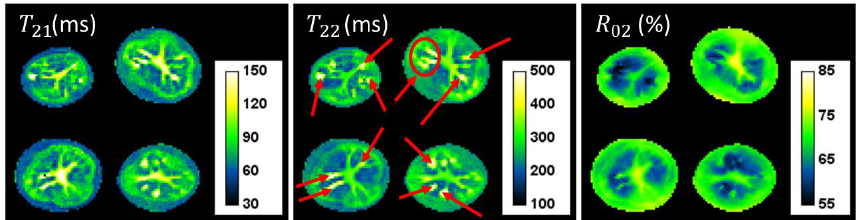
Figure 2. 𝑇 21 ,𝑇 22 and 𝑅 02 maps for 14 WAH, red arrows indicate the location of the defects. Figure 2. T 21 , T 22 and R 02 maps for 14 WAH, red arrows indicate the location of the defects. Regarding classification, the number of classes that met the compromise require- ments described above was six. Figure 3 depicts the classification results for 14, 23, 25, 27,